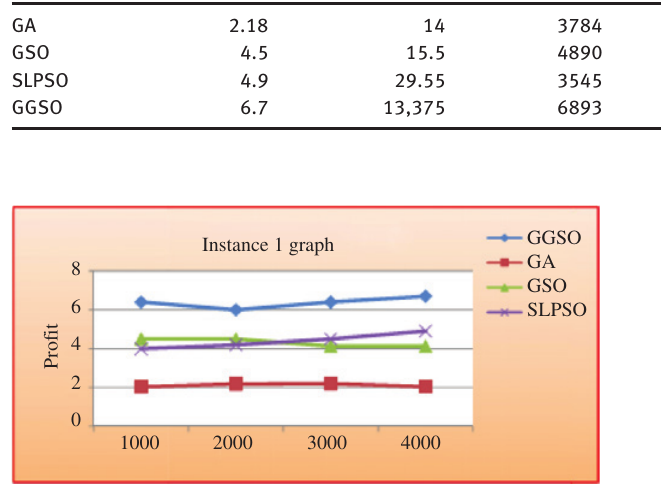
Figure 3: Performance of Profit Plot Proposed Against Existing Algorithm for Instance 1.